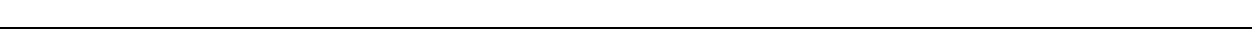
Fig. 3 DLL1 instruct macrophage maturation in vitro. a Flow cytometry of Ly6C hi monocytes from Cx3cr1 GFP/ + mice cultured for 3d on IgG-Fc (con) or DLL1-Fc chimeric proteins, in the presence of 10 ng/ml CSF1. Representative of n = 5 independent experiments. b Quantitative RT-PCR analysis at d3 after culture with CSF1, CSF2. n = 2 independent experiments performed in duplicates, error bars represent s.e.m. ** p < 0.01, * p < 0.05 by one way ANOVA with Bonferroni multiple comparison post-test. c Representative analysis of proliferation by 6 h BrdU incorporation at d3. n = 3 independent experiments. d GFP + cell numbers in culture relative to input number. n = 3 independent experiments performed in duplicates, error bars represent s.e.m. ** p < 0.01 by two-way ANOVA and Bonferroni multiple comparison post-test. e Quantitative RT-PCR analysis normalized to gene expression levels of input Ly6C hi monocytes (d0). n = 4 independent experiments performed in duplicates, error bars represent s.e.m. *** p < 0.001, ** p < 0.01, * p < 0.05 by two way ANOVA with Bonferroni multiple comparison post-test. f BrdU incorporation in CD11b + cells at day 7 after 100 ng/ml CSF1 pulse. n = 3 independent experiments, error bars represent s.e.m. *** p < 0.001 by Student ’ s unpaired t -test. g Representative Annexin V/7-AAD staining gated on CD11b + macrophages, n = 3 independent experiments, error bars represent s.e.m, ** p < 0.01, Student ’ s unpaired t test. h Representative fl ow cytometry of phagocytosis (1 h) of PE-labeled dextran beads at indicated temperature, d3 of culture. n = 3 independent experiments, error bars represent s.e.m, * p < 0.05, Student ’ s unpaired t test. i Multiplex measurement of cytokine concentration in culture supernatant after stimulation with 100 ng/ml LPS (6 h) or combination of 20 ng/ml IFN γ (18 h) and LPS (6 h). n = 4 independent experiments, error bars represent s.e.m. ** p < 0.01, * p < 0.05, Student ’ s paired t test. j , k Quantitative RT-PCR analysis after stimulation with IFN γ /LPS normalized to input monocyte levels. Comparison of cells stimulated j at d3 or d6, k with or without re-stimulation with CSF1 (100 ng/ml) at d6. n = 4 independent experiments in duplicates, error bars represent s.e.m. * p < 0.05 by Student ’ s paired t